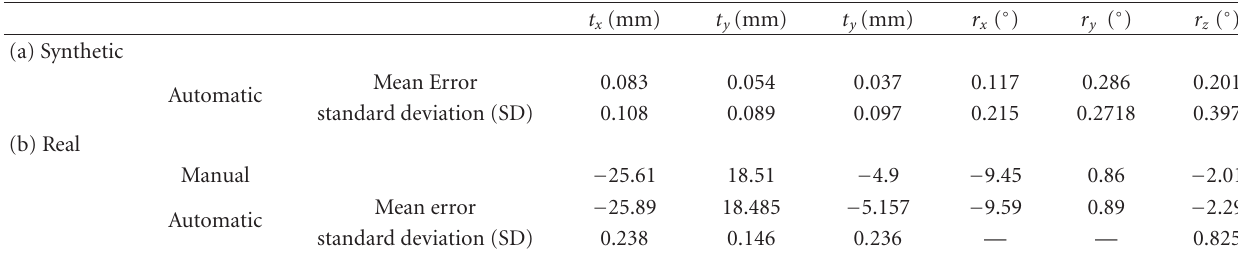
Table 1: Accuracy of the registration algorithm applied to the synthetic (a) and real (b) datasets. When the real dataset is considered, the results of the manual registration are also shown. The manual registration has been performed by an expert operator blinded to the results of the automatic registration and used as reference for the error